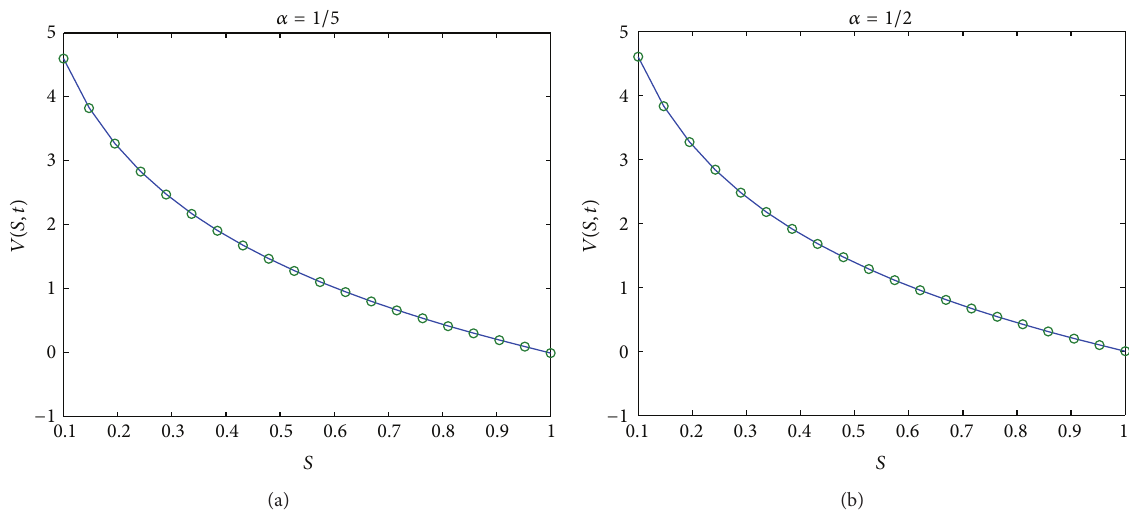
Figure 1: Solution curve with 𝑡 = 0.5 . Solid line: numerical solution; Soft dot: analytical